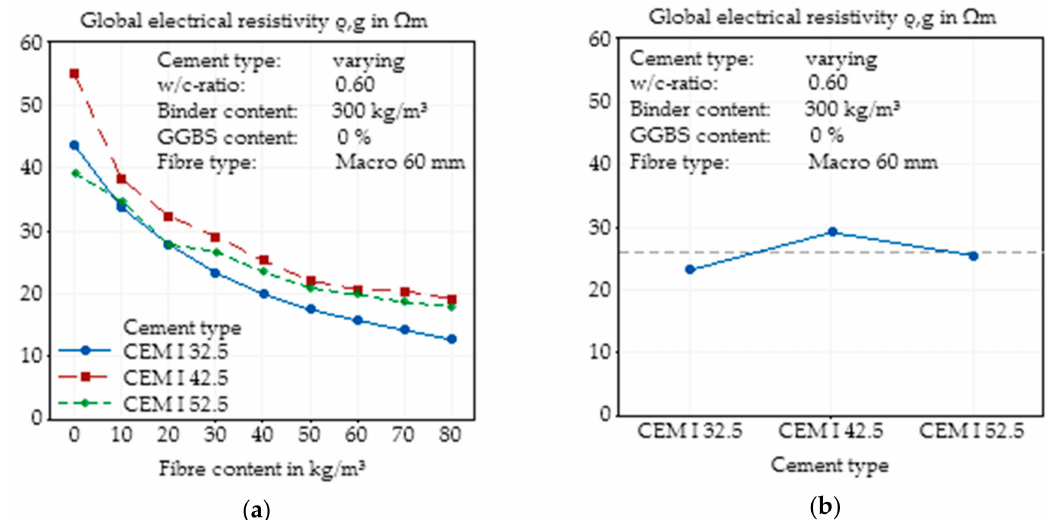
Figure 7. Effect of the cement type on the global electrical resistivity of SFRC as a function of fibre content ( a ) and main effect plot of the cement type on the global electrical resistivity of SFRC calculated by Minitab ( b ).